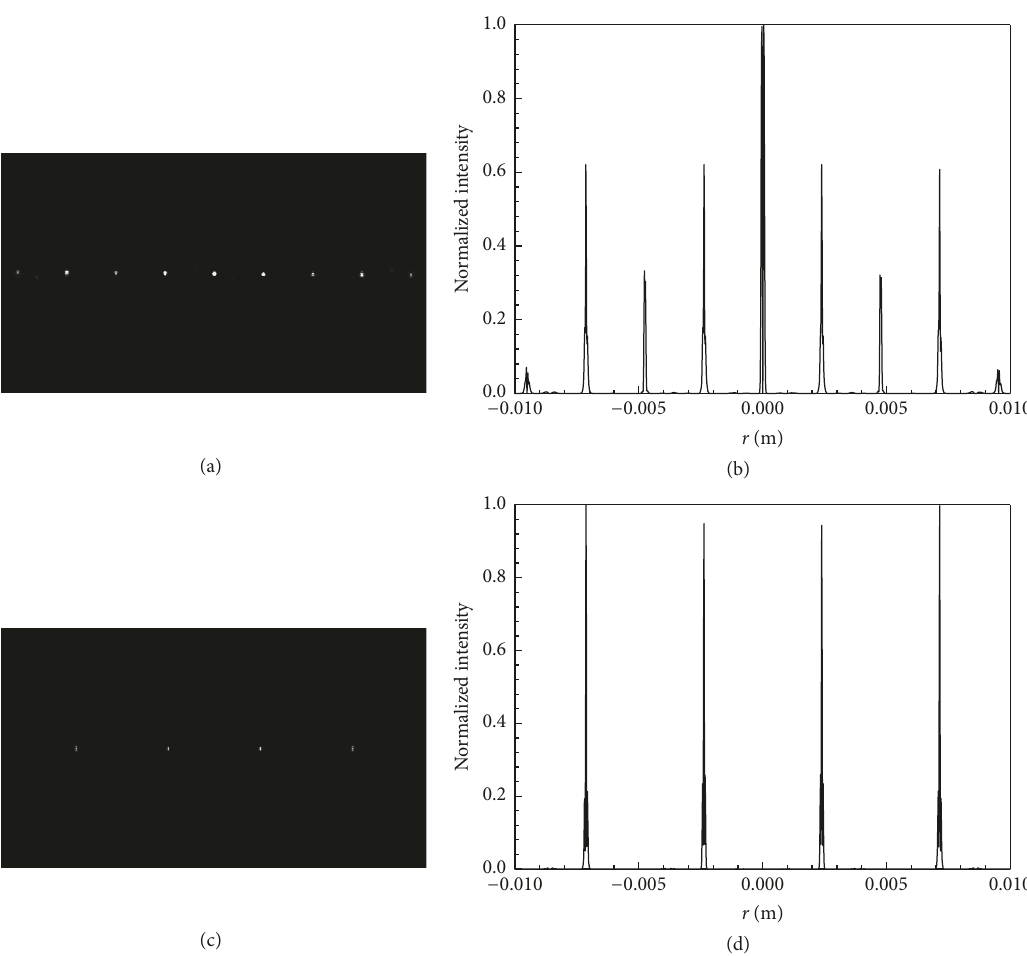
Figure 3: The detected light intensity distribution and normalized spectrum diagram. (a) The detected light intensity distribution of the original DVG. (b) The corresponding normalized spectrum diagram. (c) The detected light intensity distribution of the EDVG. (d) The corresponding normalized spectrum